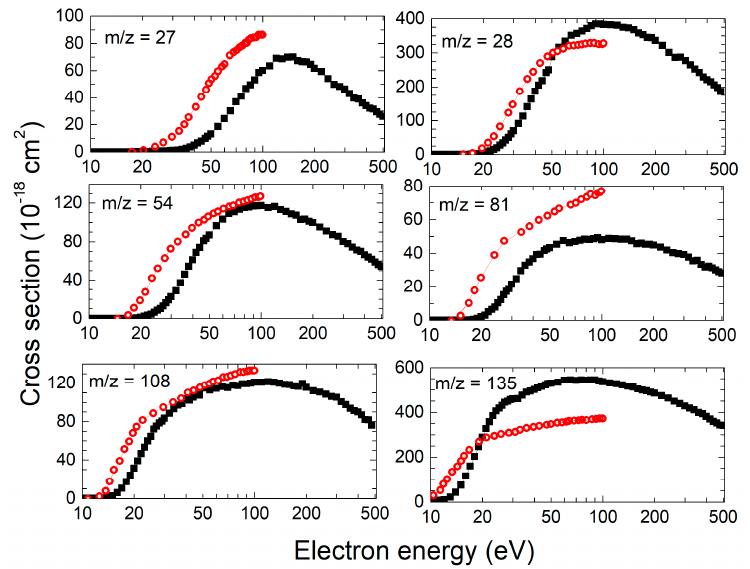
Figure 3. Partial cross sections for formation of (CHN) n+ (n = 1 to 5) and CH 2 N + . Black filled squares—present data and red open circles—from Ref. [16].